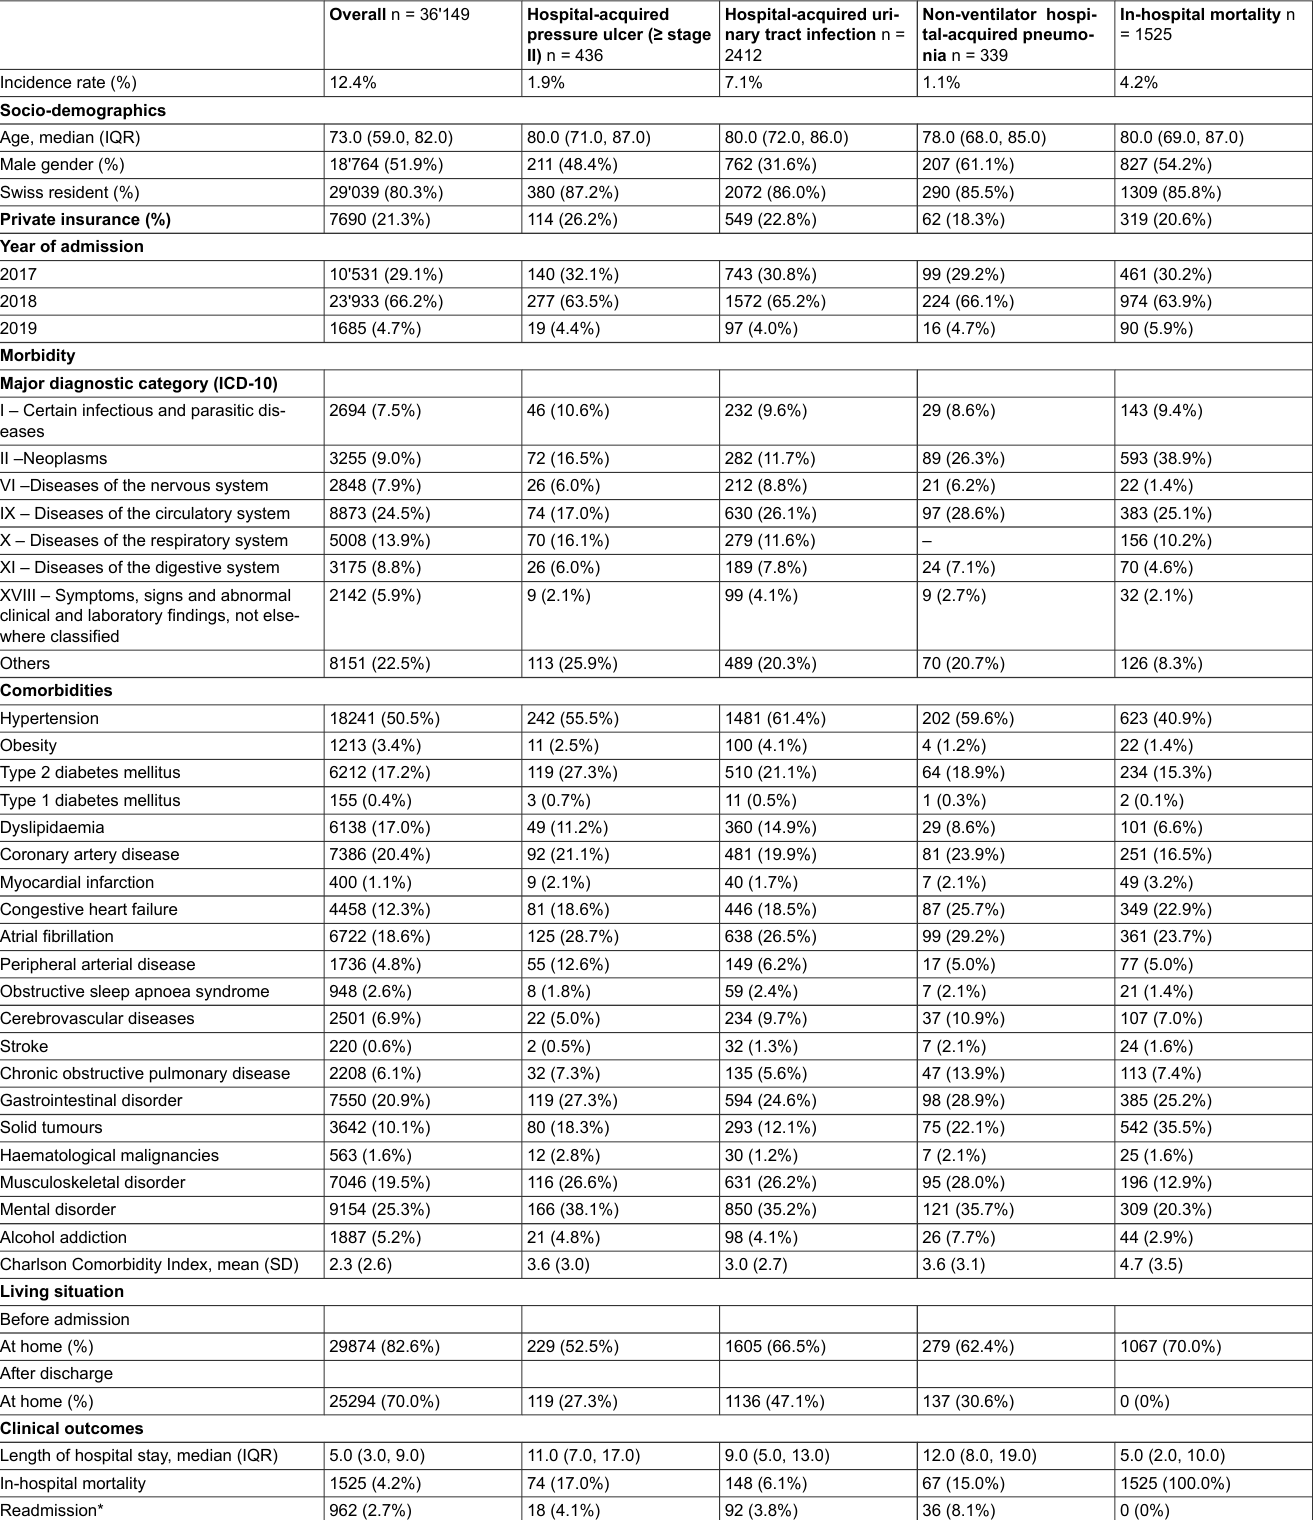
Table 2: Baseline characteristics of the study